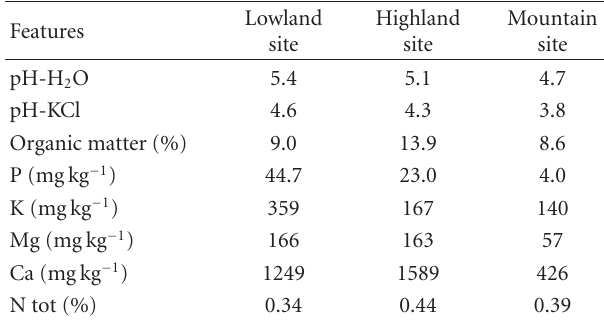
Table 1: Soil features of grass stands of studied sites (soil layer 0–